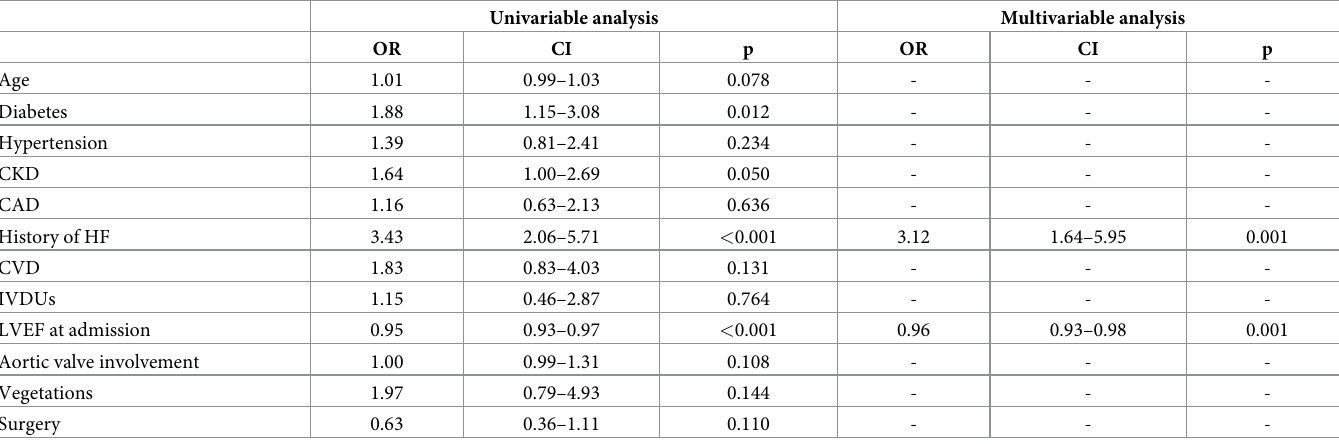
Table 5. Logistic regression analysis for in-hospital mortality.